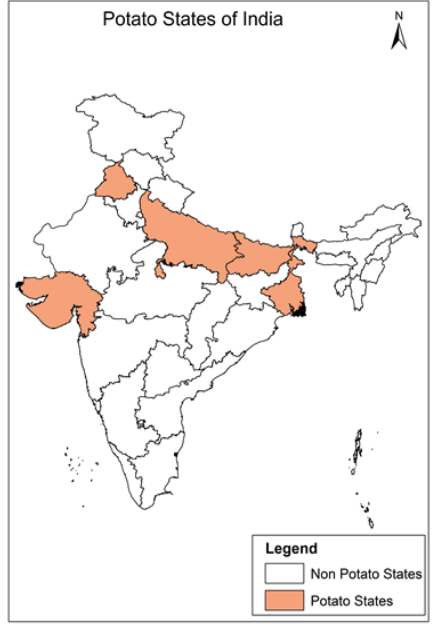
states. The contribution of the selected districts to the 92.8 %.